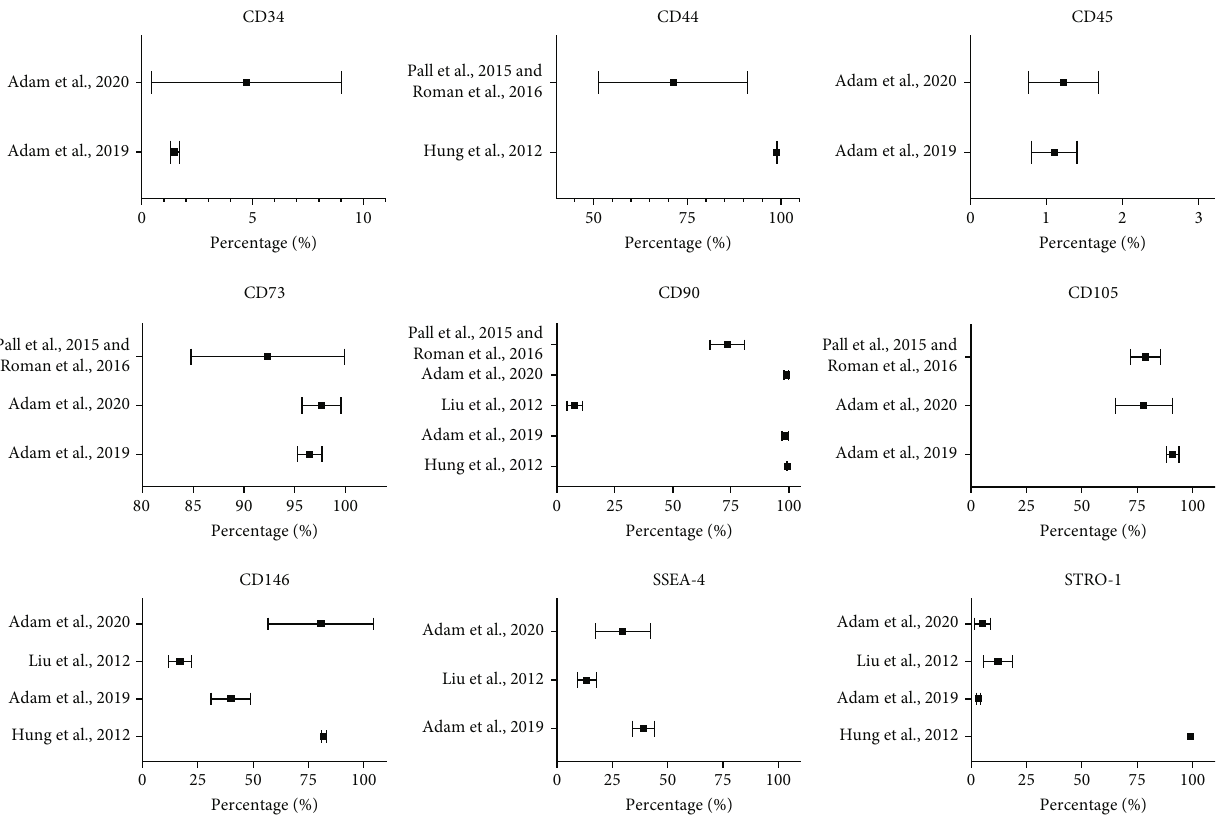
Figure 3: Expression of stem cell biomarkers from included studies by fl ow cytometry. Mesenchymal stem cell biomarkers (CD44, CD73, CD90, CD105, CD146, and STRO-1), embryonic stem cell biomarker (SSEA-4), and hematopoietic stem cell biomarkers (CD34, CD45) were analysed